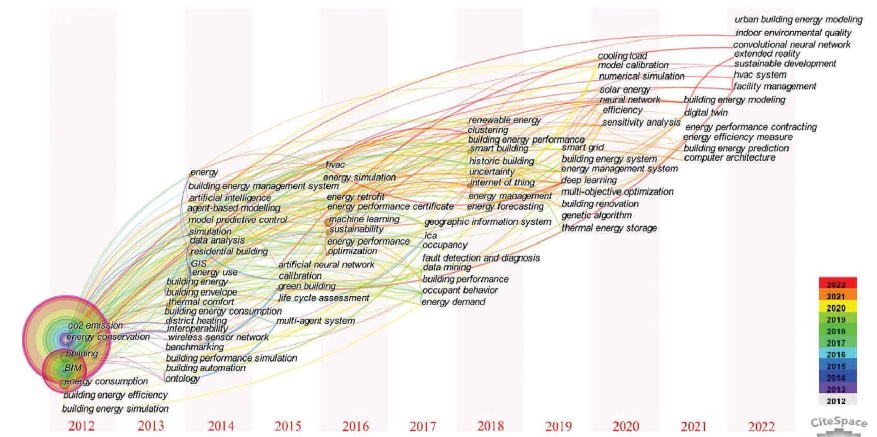
Figure 7: Keywords occurrence time slice diagram.